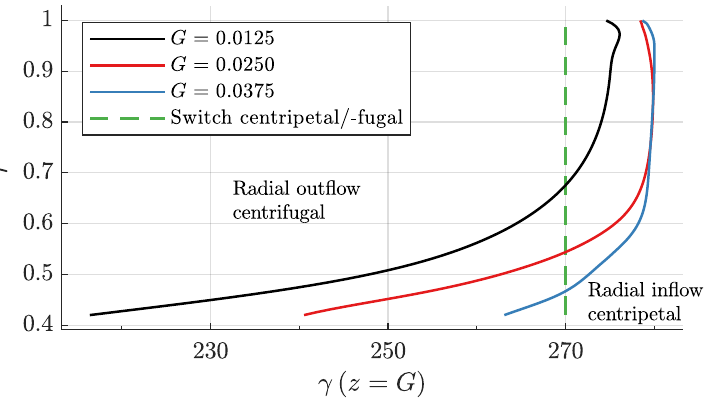
Figure 11. Wall shear stress angle γ on the stator ( z = G ) at the Reynolds number of Re = 2.5 · 10 8 , through-flow mass flow rate of ˙ m = 1.1 · 10 − 3 and at different cavity widths. Simulation